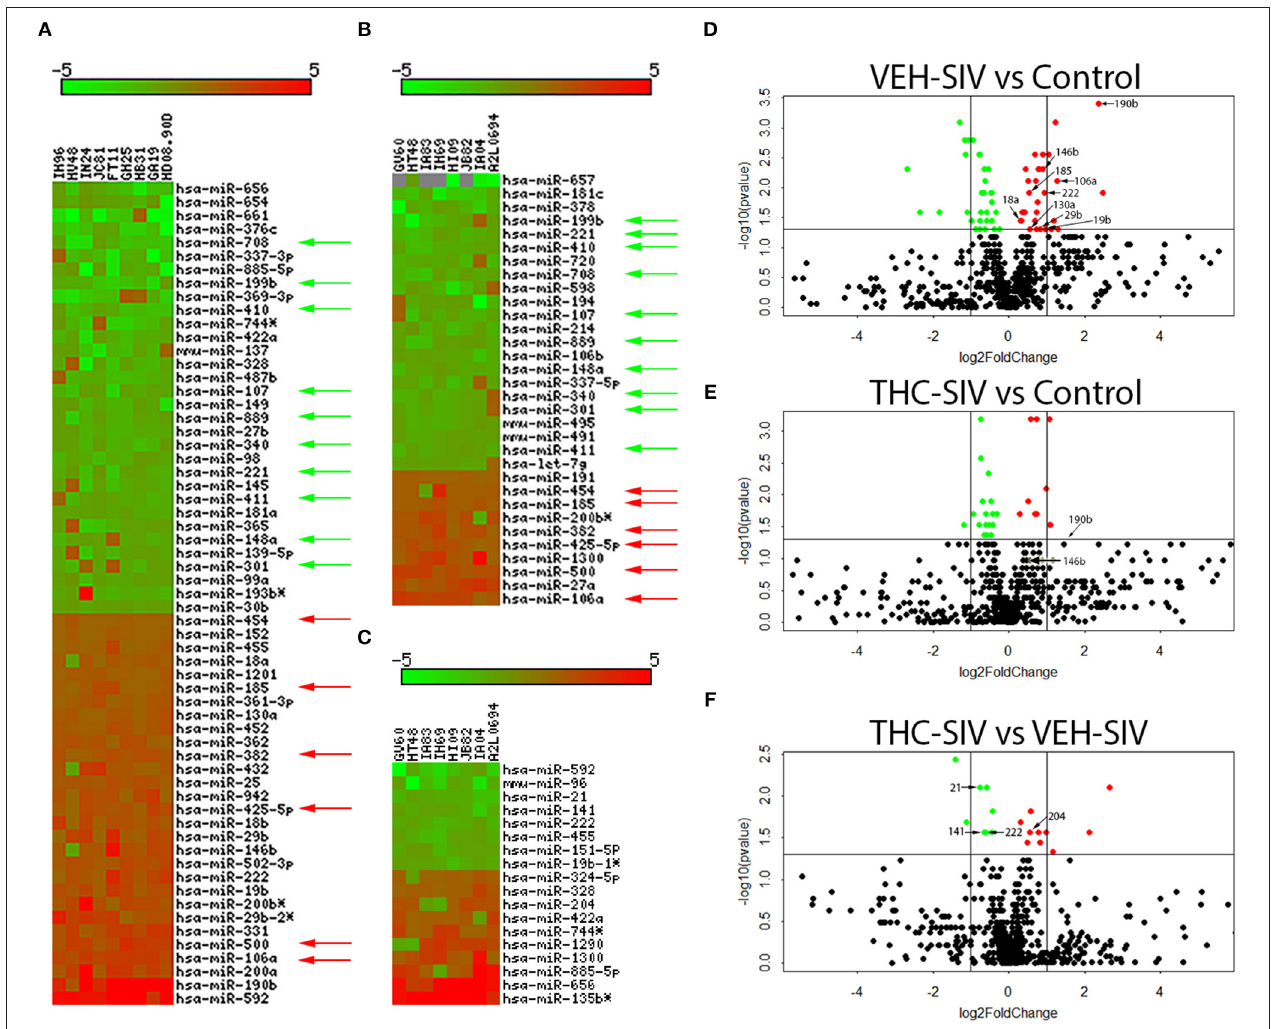
FIGURE 1 | Changes in miRNA expression in whole colon tissue of chronically SIV-infected rhesus macaques administered vehicle (VEH) or delta-9-tetrahydrocannabinol ( 1 9 -THC). The heat map shows all differentially expressed ( p ≤ 0.05) miRNAs in whole colon tissue of VEH/SIV vs. controls (A) , THC/SIV vs. controls (B) , and VEH/SIV vs. THC/SIV (C) . MiRNA species originating from the opposite arm of the precursor are denoted with an asterisk (*). Volcano plot shows the relationship between fold-change (X-axis) and statistical significance (Y-axis) of differentially expressed miRNAs in VEH/SIV (D) and THC/SIV (E) rhesus macaques relative to controls and in THC/SIV relative to VEH/SIV rhesus macaques (F) . The vertical lines in (D–F) correspond to 2.0-fold up and down, respectively, and the horizontal line represents p ≤ 0.05. The negative log of statistical significance ( p- value) (base 10) is plotted on the Y-axis, and the log of the fold change base (base 2) is plotted on the X-axis in (D–F) . Green and red arrows indicate, respectively, downregulated and upregulated miRNAs common to VEH/SIV and THC/SIV rhesus macaques. The location of miRNAs of interest is denoted with arrows in (D–F) without the prefix (miR) due to space limitations.